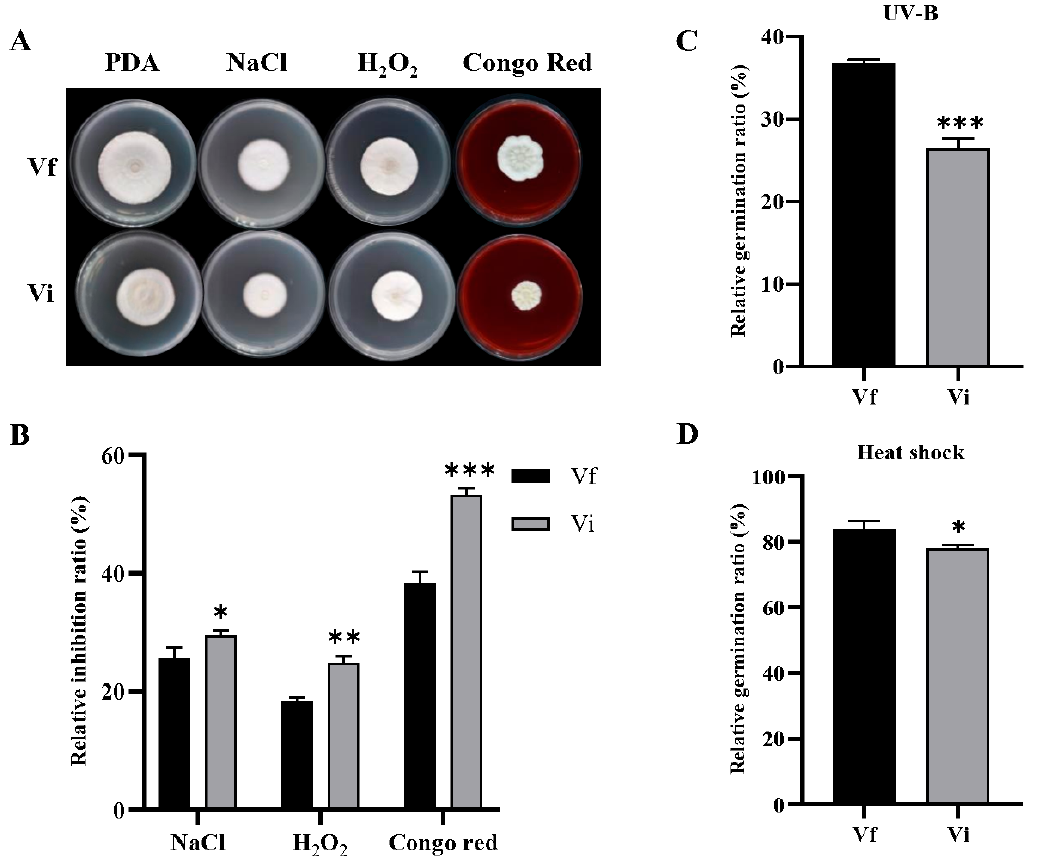
Figure 6. Resistance of strains to stress. ( A ) Colony morphology of Vf and Vi in PDA containing different chemicals. ( B ) The relative inhibition rate of the strains cultured on the medium containing NaCl, H 2 O 2 , and Congo Red after 10 days. ( C ) Relative germination rate of strains after 24 h UV-B irradiation. ( D ) The relative germination rate of strains at 40 °C heat shock after 24 h. * p < 0.05, ** p < 0.01, *** p < 0.001.